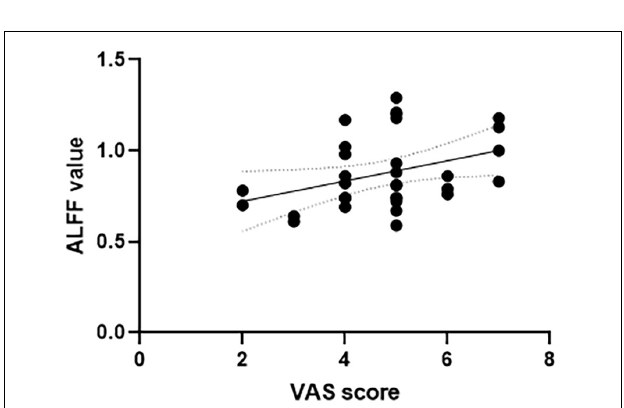
FIGURE 3 | Correlation between VAS scores and ALFF value of the right superior parietal gyrus in the slow-4 frequency band of 0.027–0.073 Hz. VAS, Visual Analog Scale; ALFF, amplitude of low-frequency